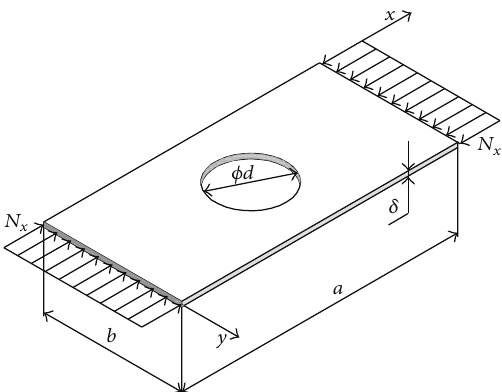
Figure 6: A rectangular plate with a circular hole.